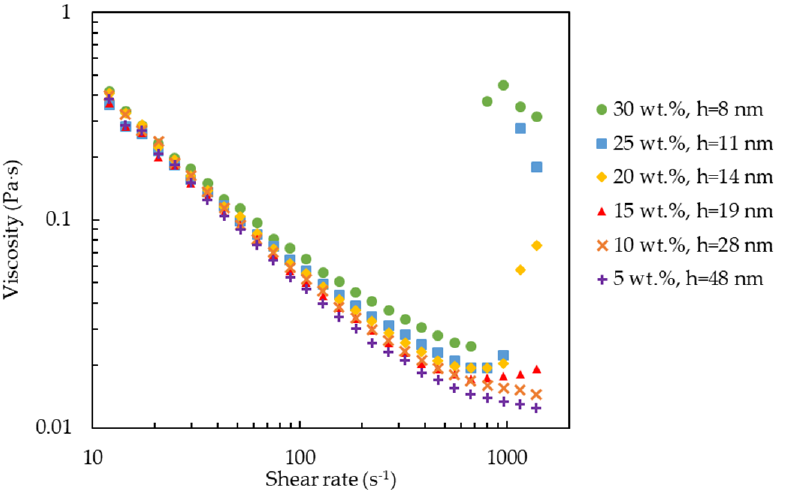
Figure 5. The viscosity of silica-PEO suspensions against shear rate at C p = 0.04 mg ∙ m − 2 . The PEO molecular weight was fixed to 1000 kDa ( R g = 61 nm). The different symbols denote different silica concentrations. In this condition, when the silica concentration was above 15 wt. %, the suspensions showed shear-thickening, meaning that they gelled. These results agreed with those in Figure 3 showing that the suspensions with h below 19 nm gelled at R g = 61 nm.